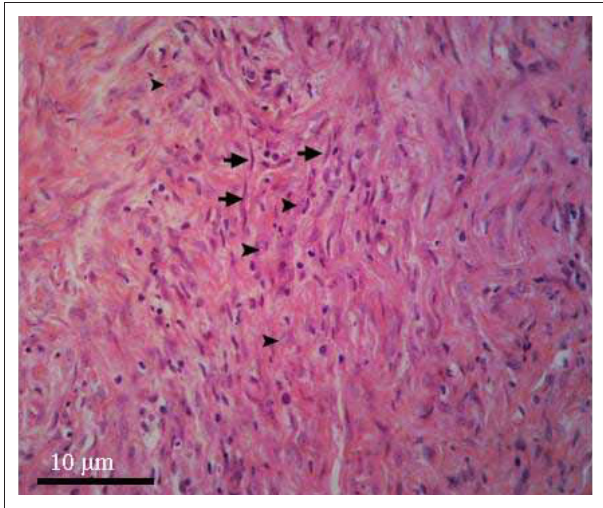
FIGURE 5: Spindle cells, with elongated wavy nuclei like Schwann cells (arrows) and fibroblasts (arrowheads) with oval nuclei. Sample stained with haematoxylin and eosin and shown here at 640× magnification .